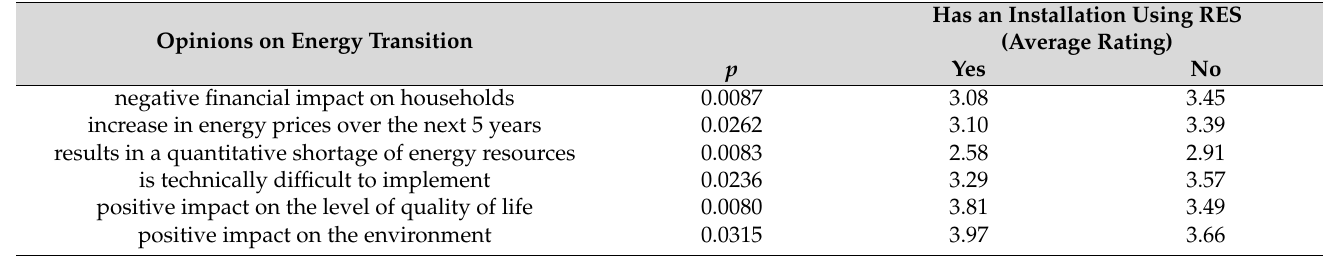
Table 9. Opinions on energy transition according to possession of renewable energy